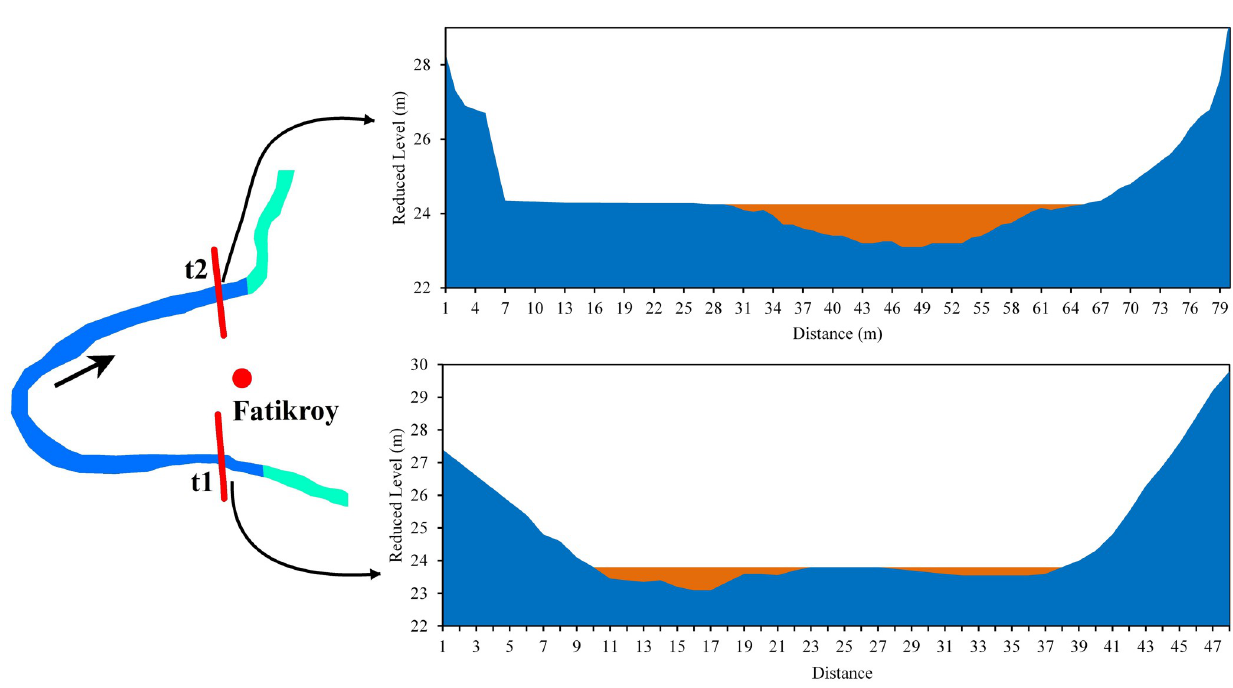
Fig 11. Cross-section across the Manu River at Fatikroy (a) t1 (b) t2.